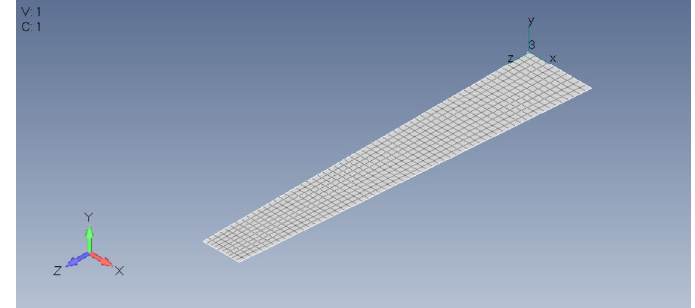
Figure 7. Base wing Aerodynamic Panels.